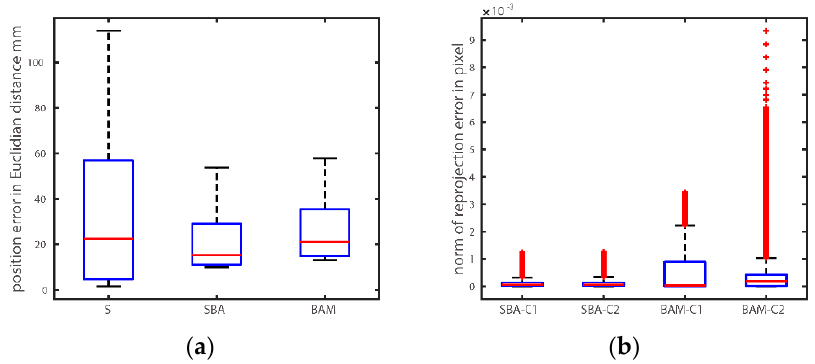
Figure 7. Boxplot of ( a ) position error, ( b ) reprojection error of each camera.